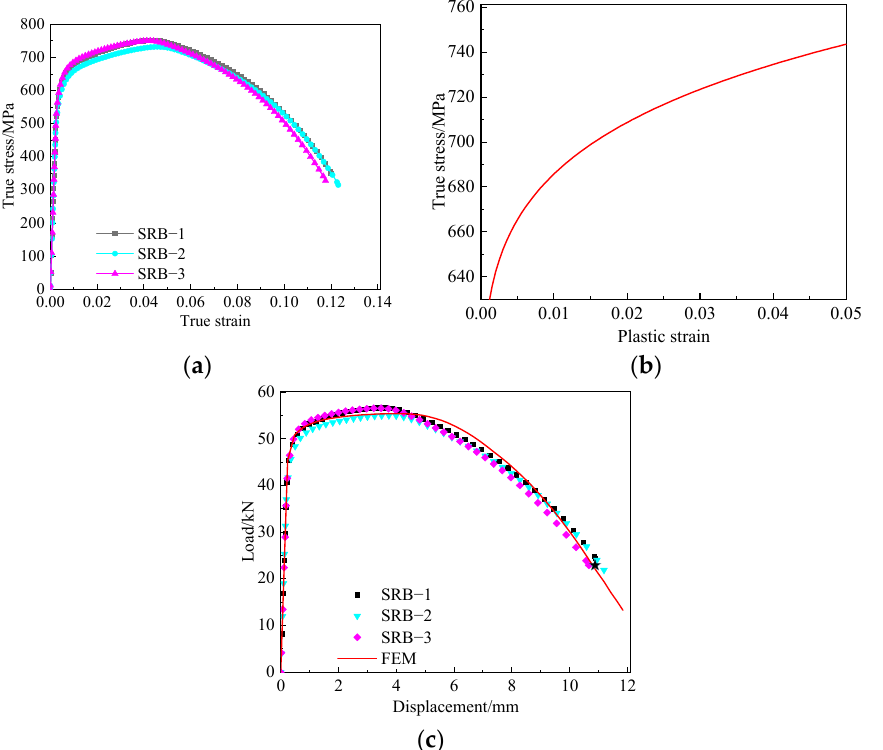
Figure 6. X80 pipeline steel stress ‐ strain curve: ( a ) true stress ‐ strain curve, ( b ) Johnson–Cook hardening curve, and ( c ) comparison of finite element and experimental results.